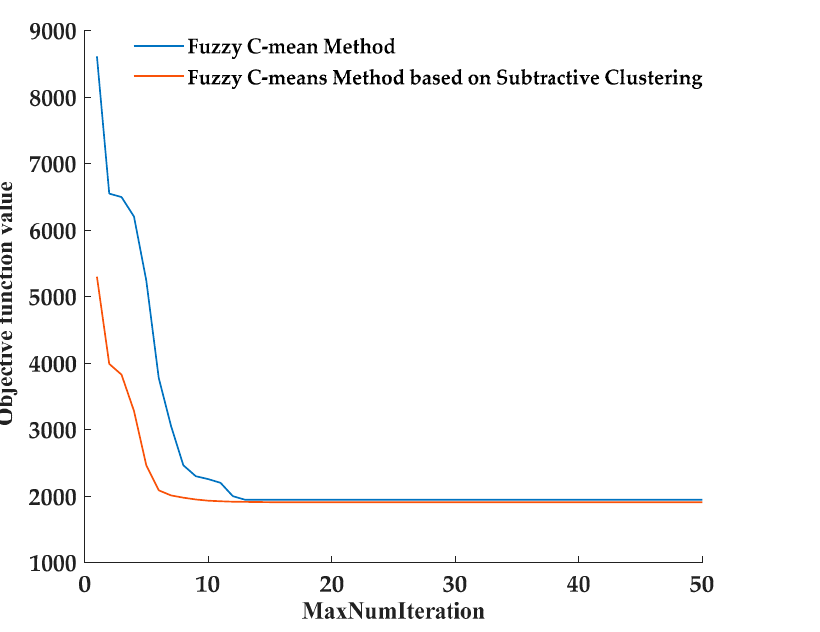
Table 2. Comparison of evaluation index results.